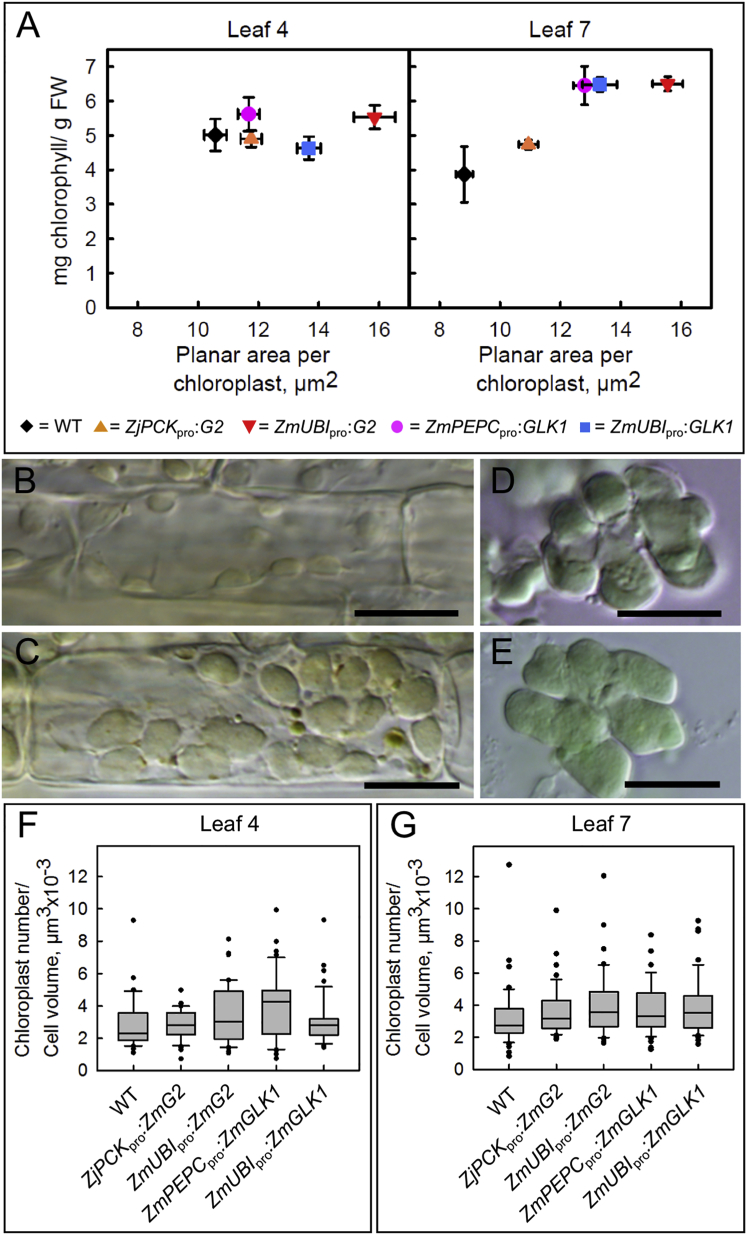
Chloroplast Size, but Not Number, Is Increased in Bundle Sheath Cells of ZmG2 and ZmGLK1 Overexpression Lines(A) Relationship between total leaf chlorophyll content and chloroplast planar area in bundle sheath cells of wild-type (WT) and T1 transgenic lines. Values are mean ± SEM (n = 3 individuals for chlorophyll content; n = 45 cells [15 cells/3 individuals] for chloroplast area). Chloroplast size was significantly increased in leaf 7 of all four transgenic lines relative to WT and in leaf 4 of lines constitutively expressing ZmG2 or ZmGLK1 (by a Games-Howell test of variance, p < 0.05). The phenotypic consequences of relatively weak transgene expression from the BS-preferential ZjPCKpro were less dramatic than with the constitutive promoters.(B–E) Representative bundle sheath (B and C) and mesophyll (D and E) cells from WT (B and D) and ZmUBIpro:ZmG2 (C and E) lines. Scale bars, 10 μm.(F and G) Boxplots showing chloroplast numbers in bundle sheath cells of leaf 4 (F) and leaf 7 (G) (n = 45 cells [15 cells from each of 3 individuals representing at least two independent lines] in each case). Boxplot whiskers indicate the range of observations.See Table S1 for details of transgenic lines used, Figure S1 for transgene copy number analysis, Figure S2 for transgene transcript levels, and Table S2 for a complete set of measurements.